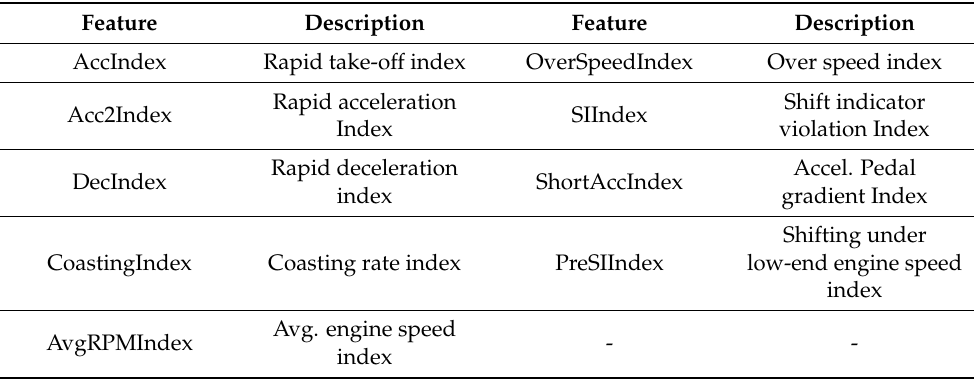
Table 1. Fuel economy prediction model input